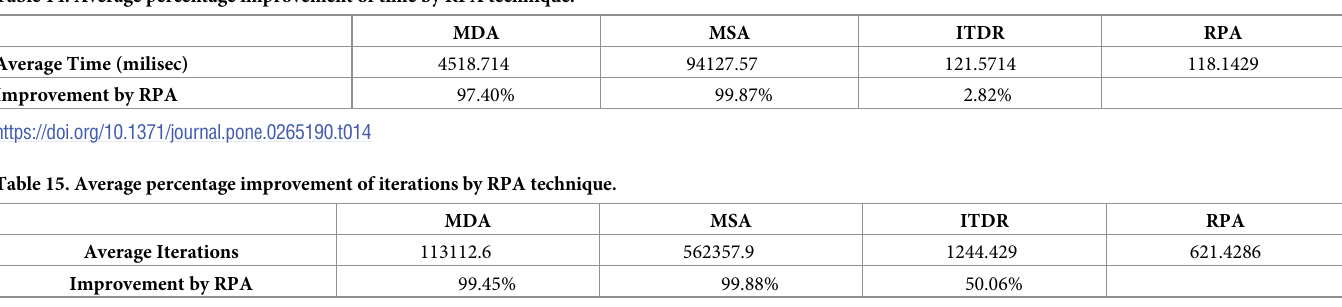
Table 14. Average percentage improvement of time by RPA technique.